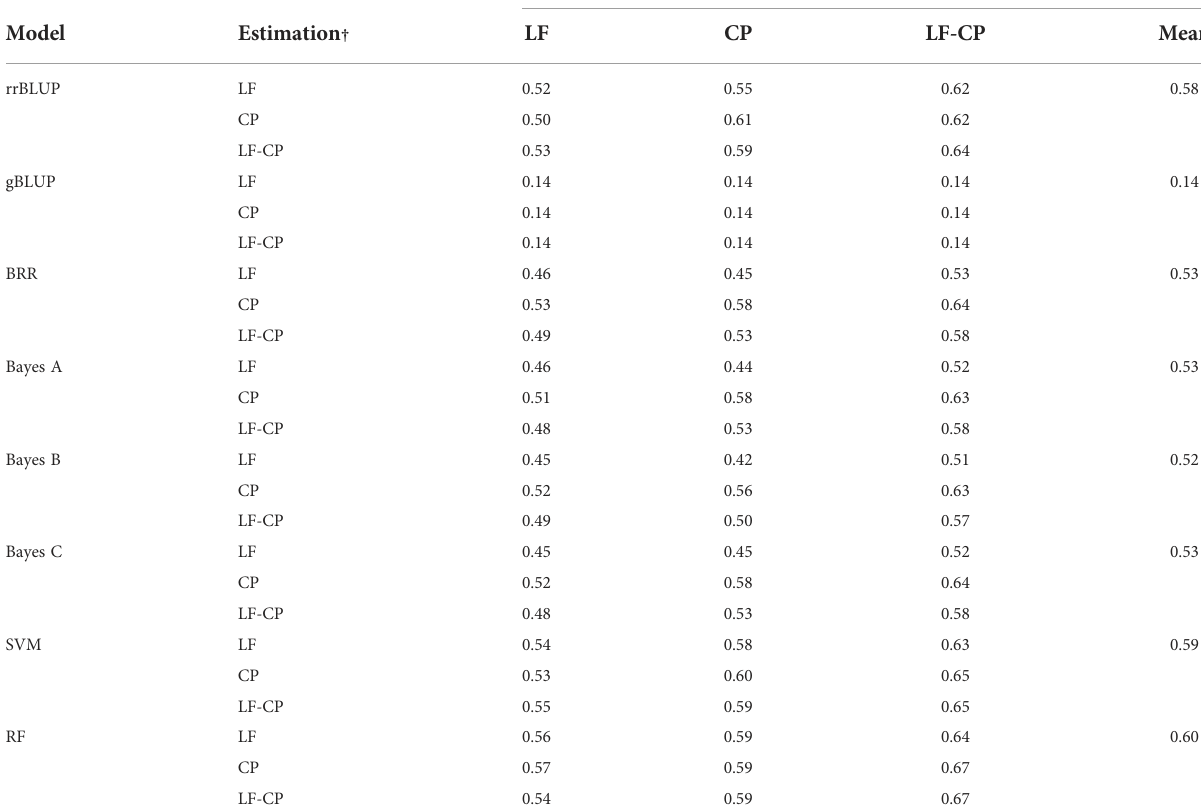
TABLE 5 The genomic prediction accuracy of total biomass yield in the P392 population validated within and across locations.